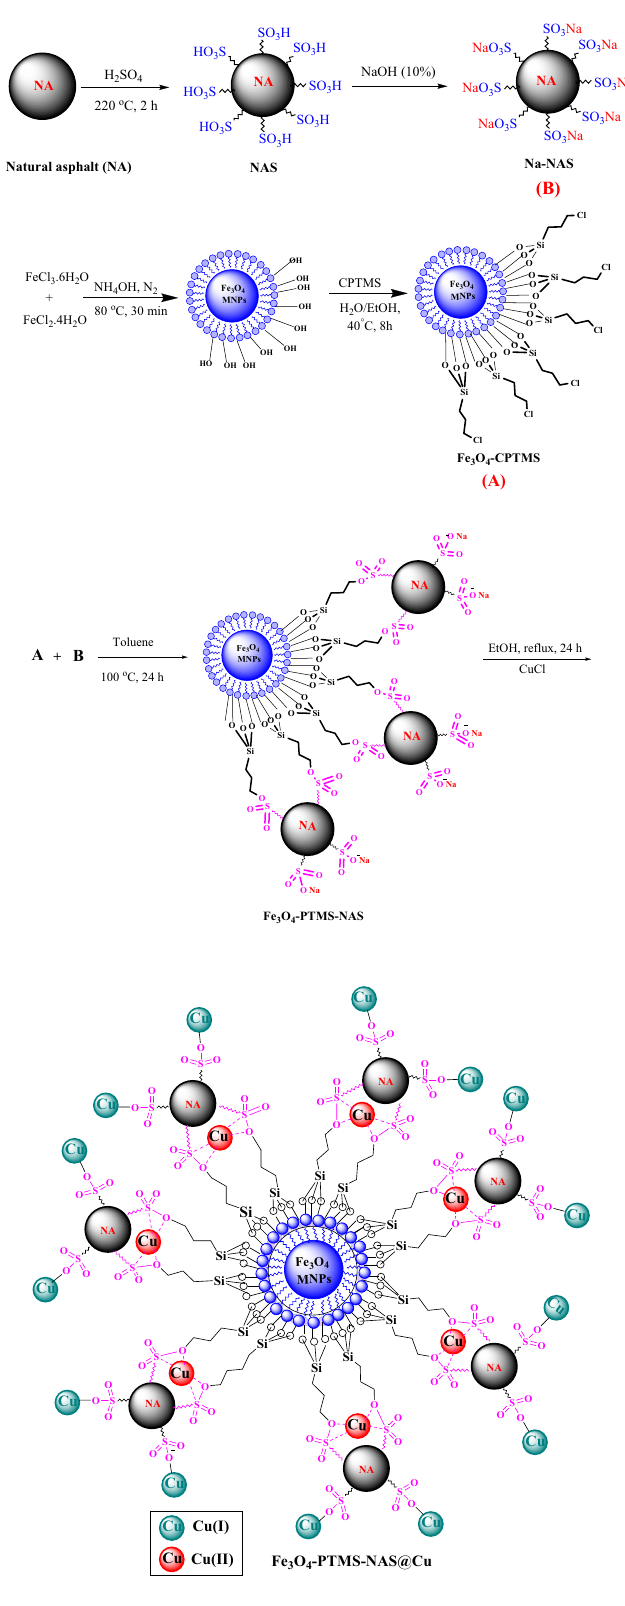
Scheme 2. The general route for the synthesis of Fe 3 O 4 -PTMS-NAS@Cu